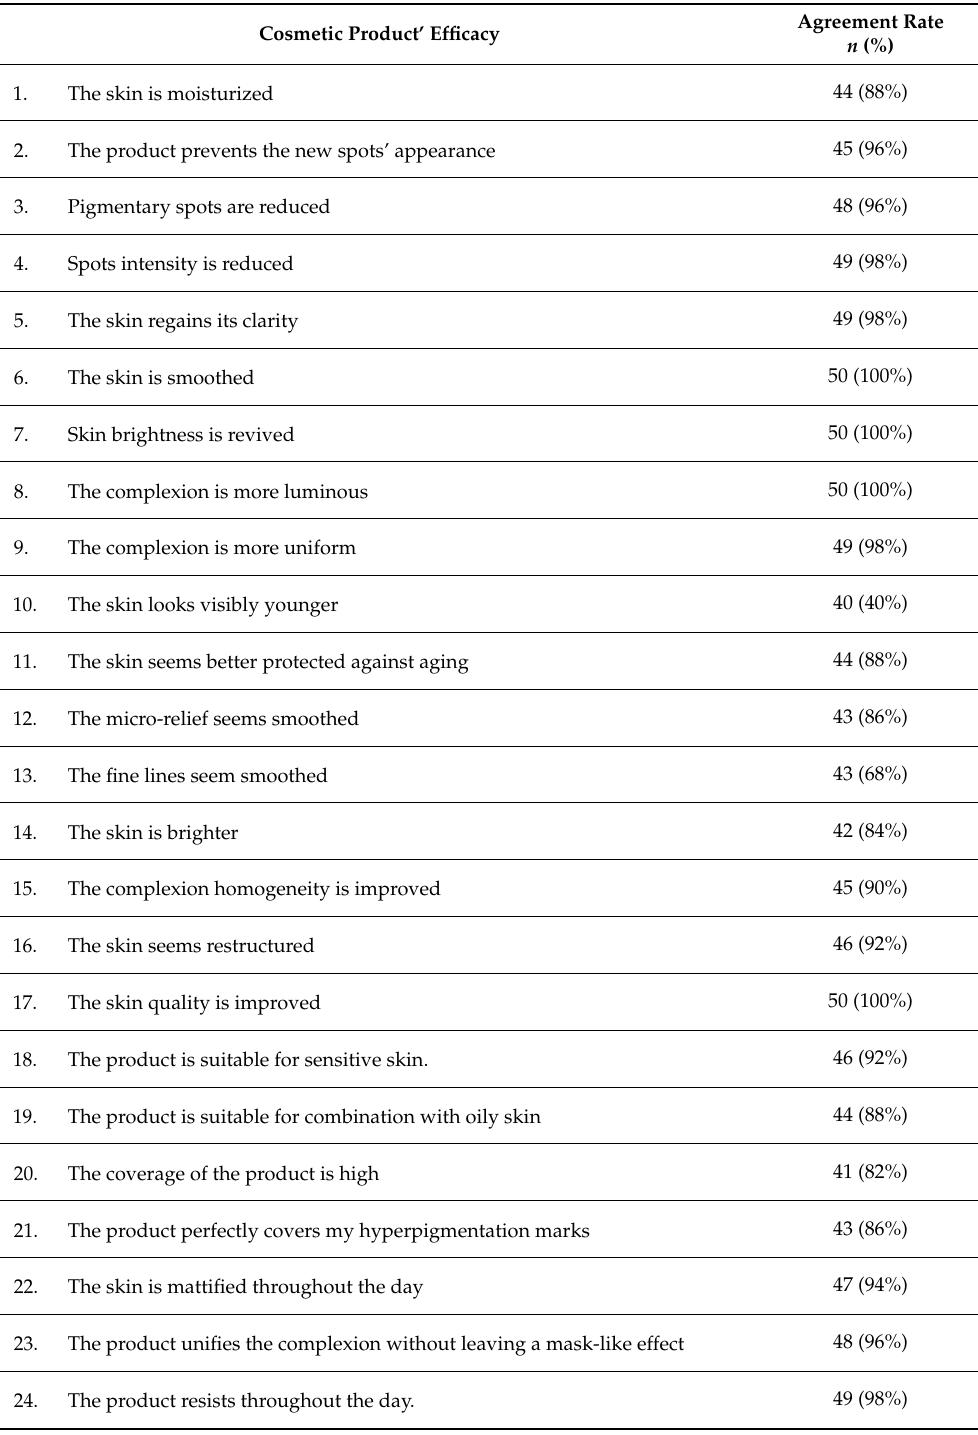
Table 3. Final cosmetic qualities and efficacy